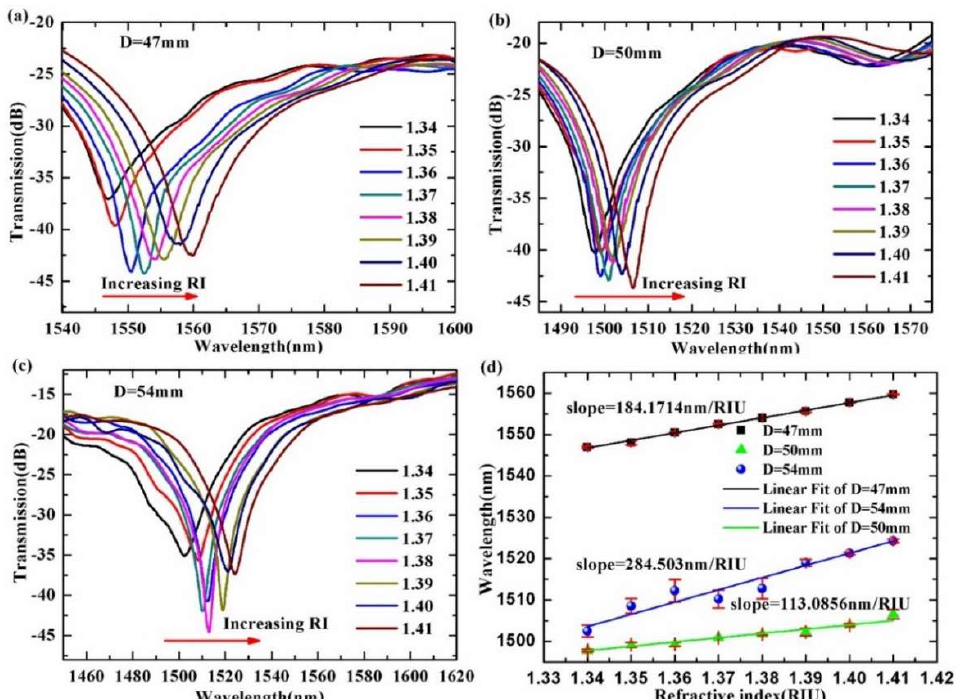
Figure 3. Transmission spectra and the wavelength shift trend of the corresponding valley of the SMF-UHCF-SMF structure immersed in solution with different RIs. ( a ) the bending diameter of the UHCF is 47mm; ( b ) the bending diameter of the UHCF is 50mm; ( c )the bending diameter of the UHCF is 47mm; ( d ) the wavelength shift trend of the corresponding valley with different RIs.